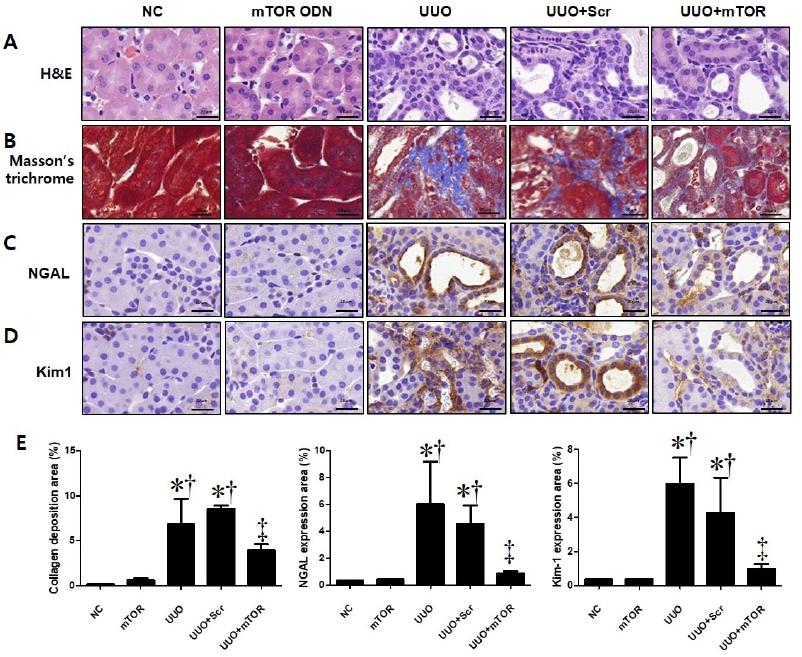
Figure 2. Effects of synthetic mTOR ODNs on UUO − induced damage and tubular injury in mouse kidney tissue. The effects of mTOR ODNs on morphological alterations and tubular injury in UUO kidneys were investigated. Representative images of each group were evaluated for histological changes through ( A ) H&E staining and ( B ) Masson’s trichrome staining. Images of immunohisto ‐ chemical staining of ( C ) neutrophil gelatinase − associated lipocalin (NGAL) and ( D ) kidney injury molecule − 1 (Kim − 1). These images are representative of each study group. Scale bar = 20 μ m. ( E ) Quantitative analysis of the interstitial collagen area in the trichrome stain, NGAL, and Kim − 1 ex ‐ pression areas of each group ( n = 3) performed at 400× magnification. The graphs show the percent ‐ age of collagen deposition, NGAL, and Kim − 1 positive areas. The results are expressed as the mean ± SE of three independent determinations. * p < 0.05 vs. NC group. † p < 0.05 vs. mTOR group. ‡ p < 0.05 vs. UUO or Scr group. UUO, unilateral ureteral obstruction; ODNs, oligonucleotides; mTOR, mammalian target of rapamycin; NC, normal control; mTOR, injected with mTOR ODNs; UUO, UUO surgery; UUO + Scr, underwent UUO surgery and injected with scrambled ODNs; UUO + mTOR, underwent UUO surgery and injected with mTOR ODNs.